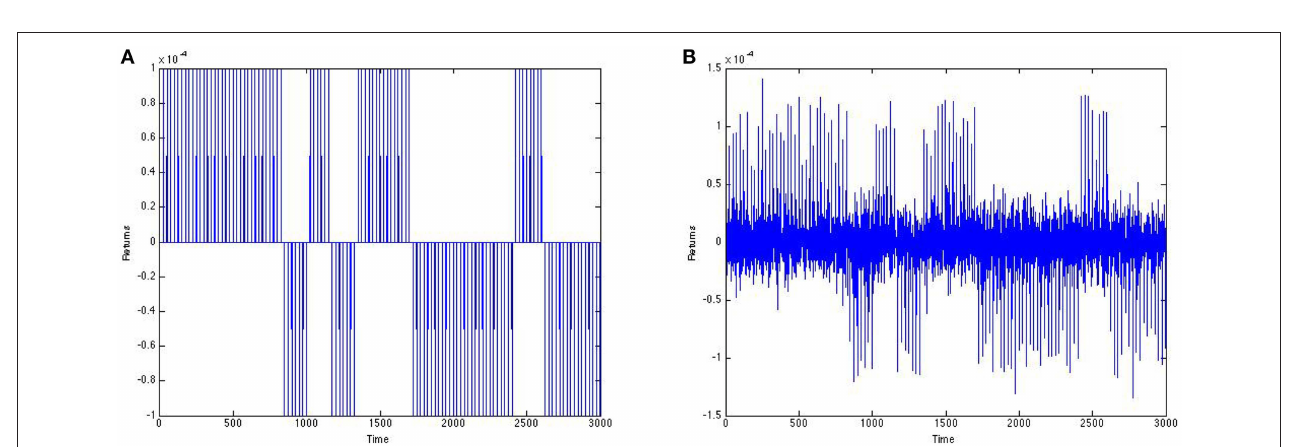
FIGURE 16 | Returns before and after noise from small scale traders. (A) Before noise. (B) After noise.